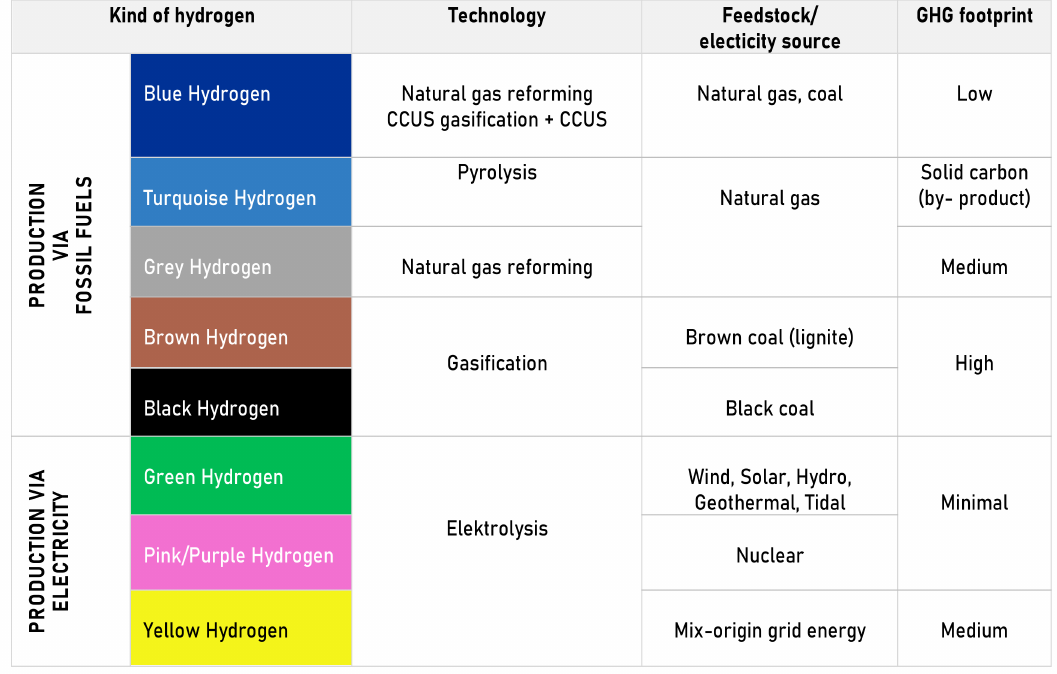
Figure 1. Hydrogen classification and its use. Source: